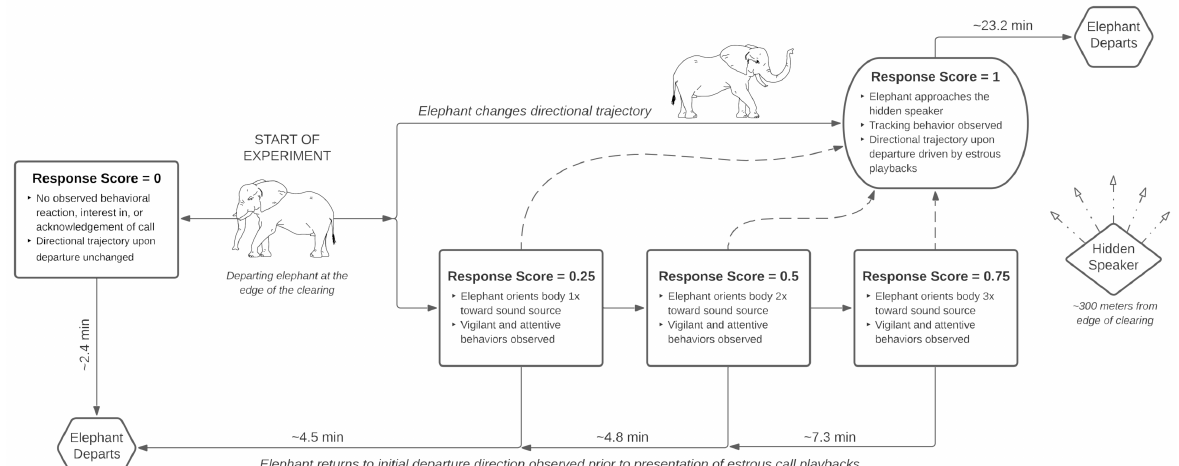
Figure 2. Flowchart of the estrous playback experimental design and suite of responses observed from n = 19 male African elephants. Upon departure from the Mushara waterhole clearing, males are presented with a prerecorded estrous rumble once per minute until (1) the elephant begins to track the call, (2) the social environment changes, or (3) the elephant leaves the clearing. Response criteria are based on the presence and frequency of focal behaviors described in Table 2. Elephant responses of ≤ 0.75 departed in the same direction observed prior to playback presentation, whereas the departure direction of individuals with a score of 1 was dependent on the elephant’s position to the hidden speaker. Departing and Periscope Elephant Graphics © 2022 Monica